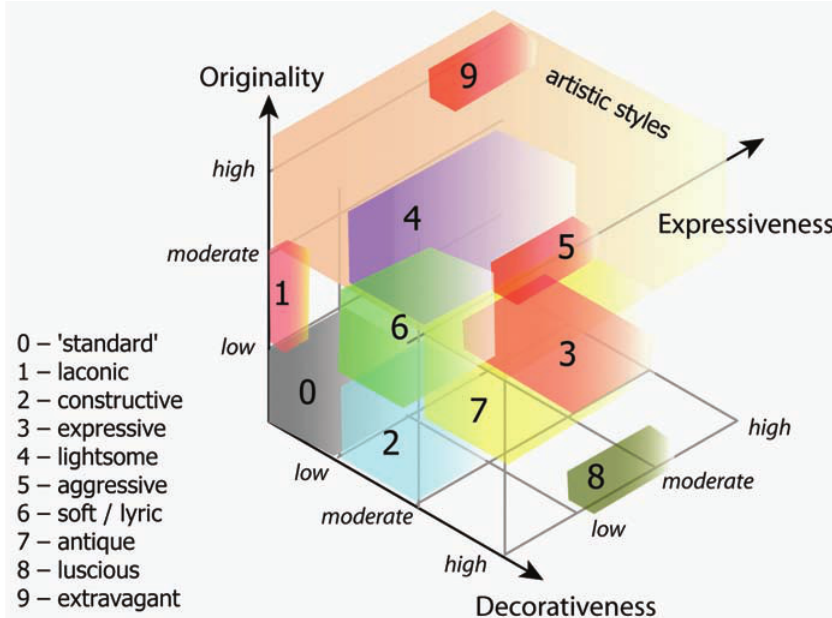
Fig. 5 . Samples of conventional styles